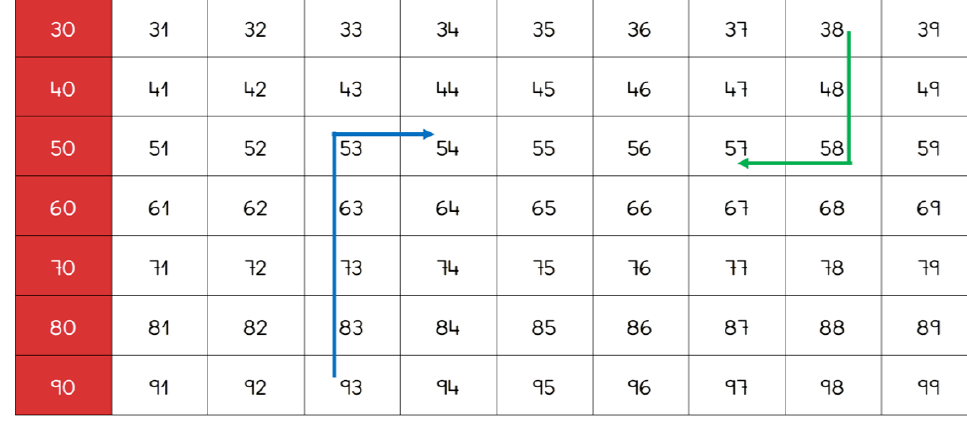
Figure 14. Detail of two path on the panel.